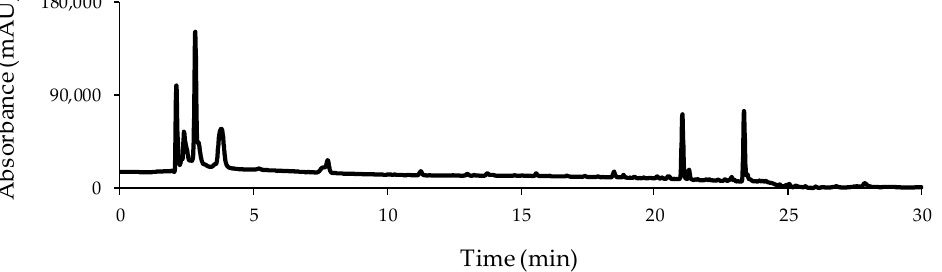
Figure 1. High performance liquid chromatography with ultraviolet detection (HPLC-UV) chromatogram at 250 nm obtained for a selected barn hen egg sample under the proposed gradient elution program (Section 2.2).